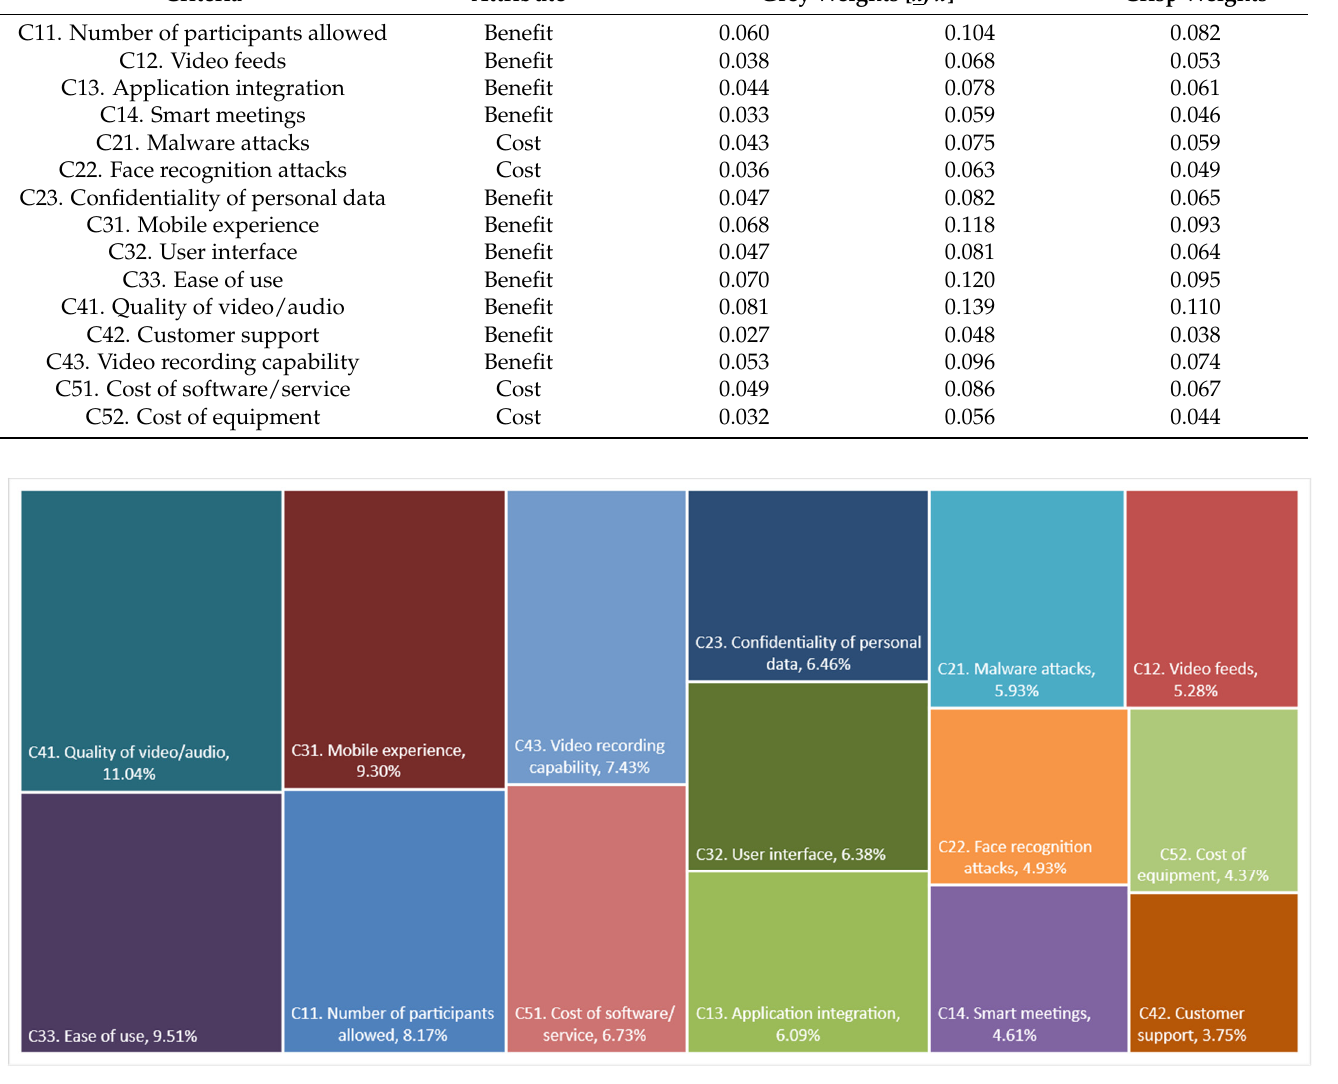
Figure 4. The significant level of criteria of G-AHP.